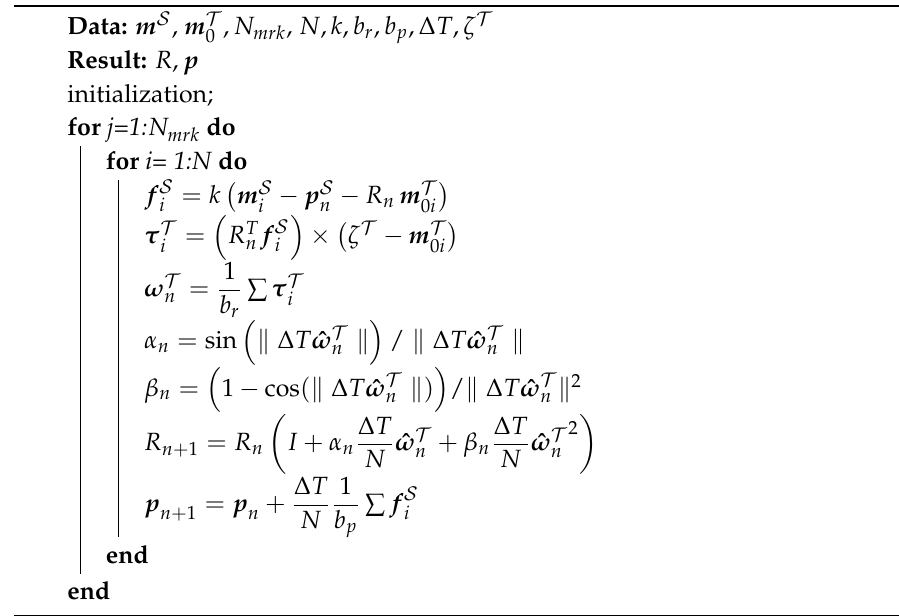
Algorithm 1: Damped least square algorithm for the filtering motion tracker’s